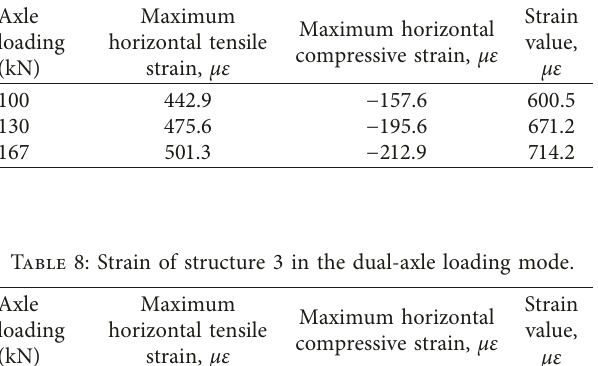
Table 7: Strain of structure 3 in the single-axle loading mode. loading